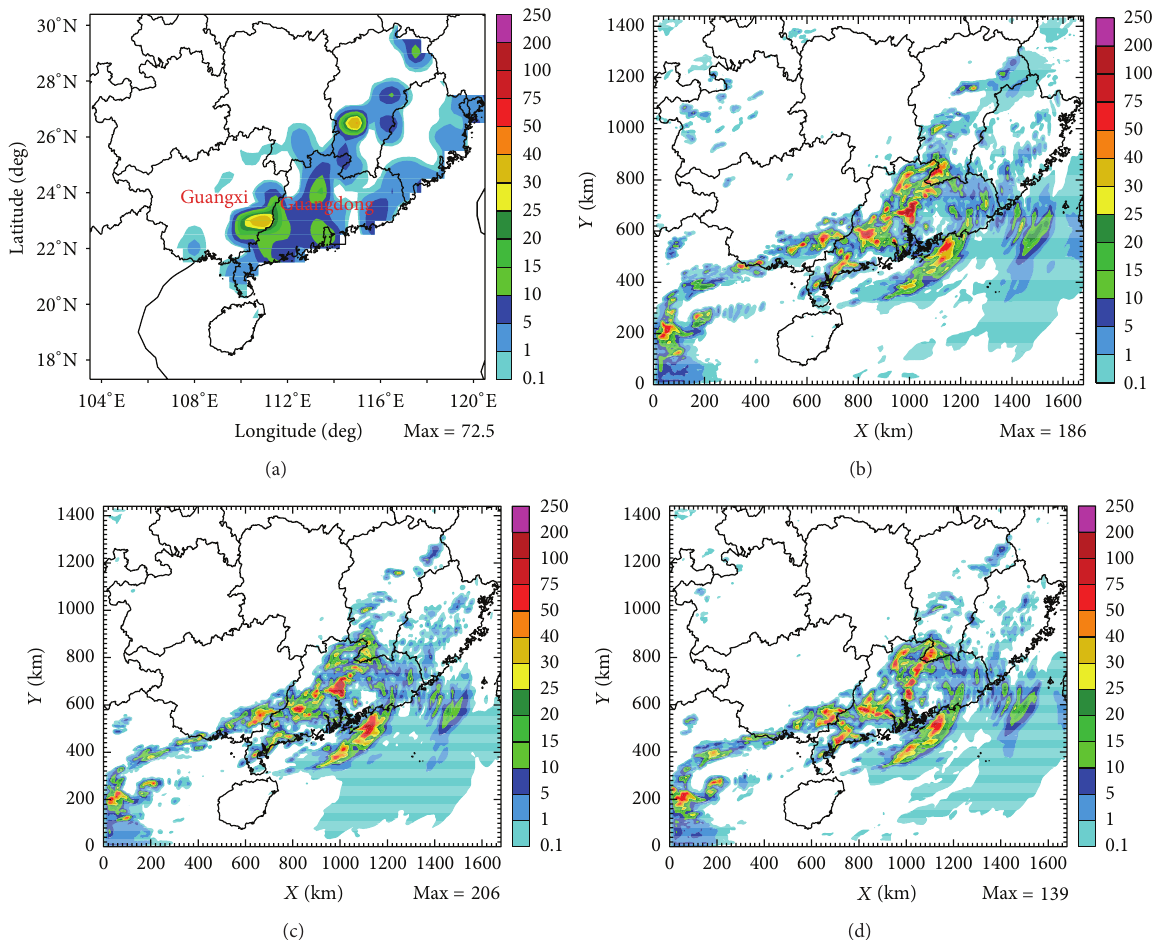
Figure 7: 3 h accumulated precipitation from (a) observations, (b) CNTL, (c) RADSND, and (d) ALLDATA between 1200 and 1500 UTC July 15, 2011 for case